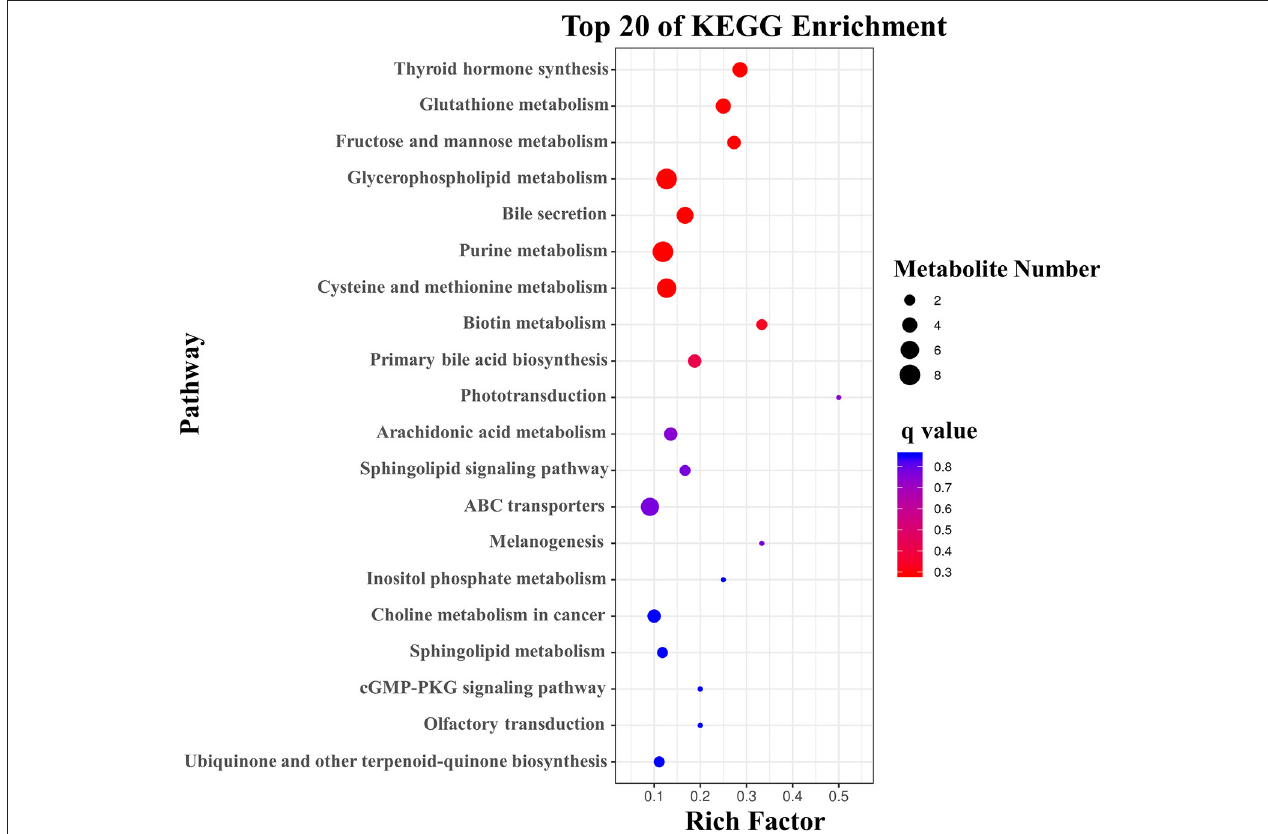
FIGURE 6 | KEGG analysis of the differential metabolites with the top 20 enrichment